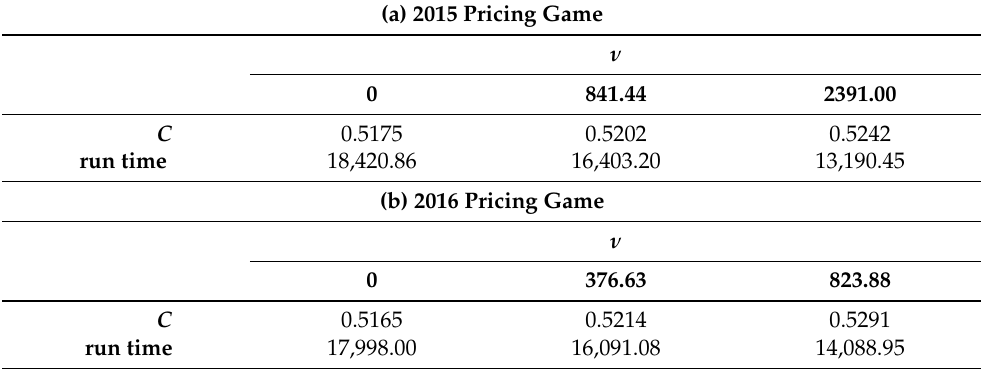
Table 9. The exact concordance probabilities together with the computing times (s) for different values for ν . The upper (lower) part focuses on the bootstrap version of the test set of the 2015 (2016) pricing